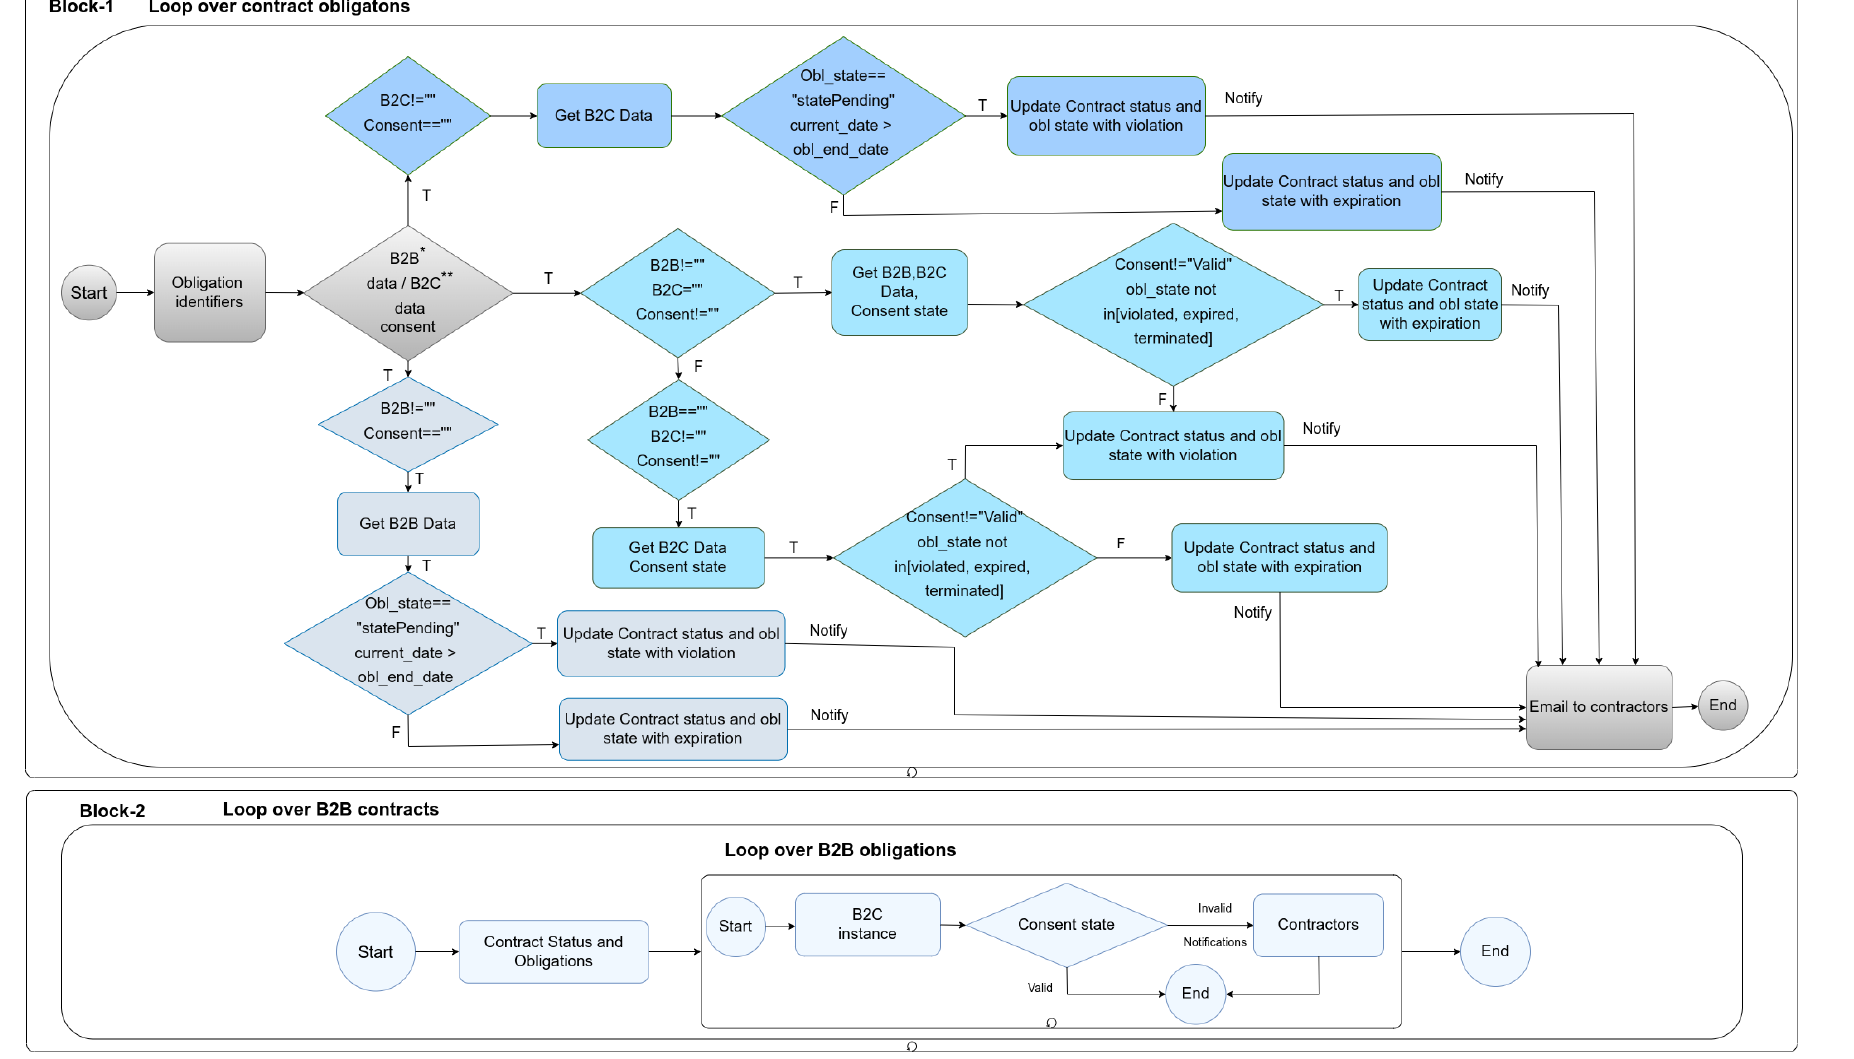
Figure 4. CCV process